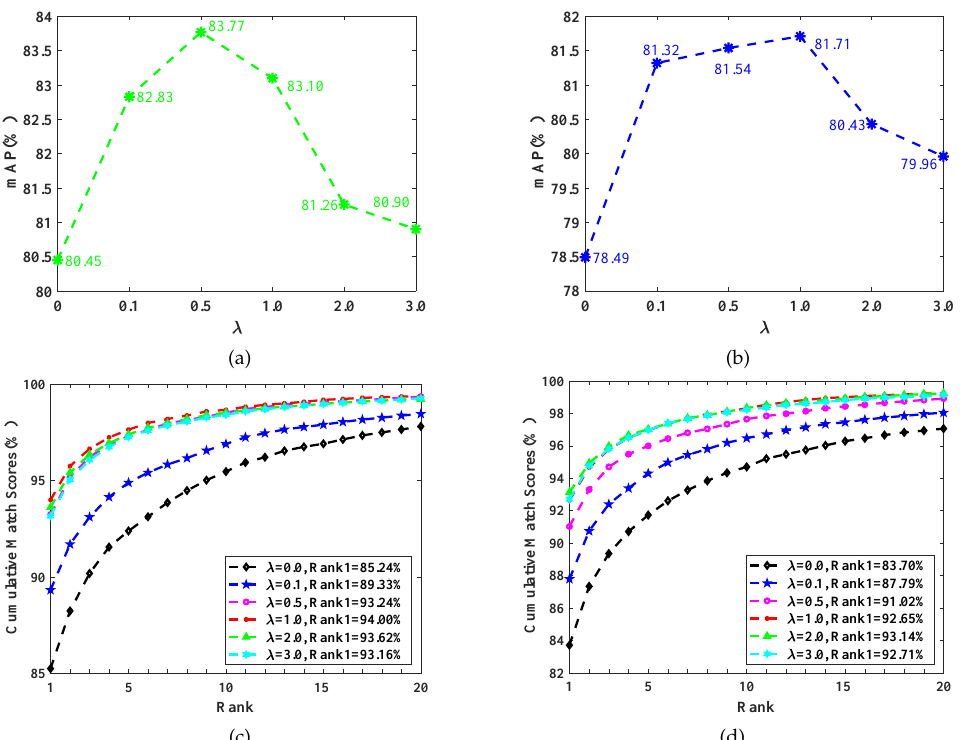
Figure 6. The performance of using different modal discrepancy restraining degrees (i.e., λ in Equation (7)) on the RegDB dataset. ( a ) V2I mAP, ( b ) I2V mAP, ( c ) V2I Rank1, and ( d ) I2V